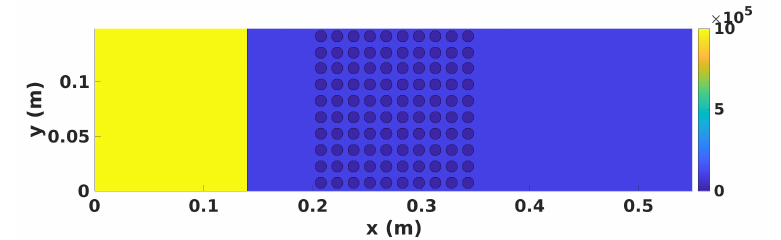
Figure 3. Geometry and initial pressure loading: 10 bar (yellow) and 1 bar